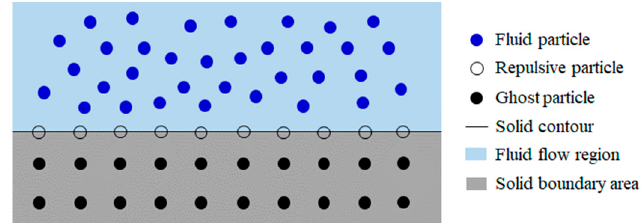
Figure 2. Treatment on the interface of different fluids: ( a ) original particles; ( b ) converted particles.